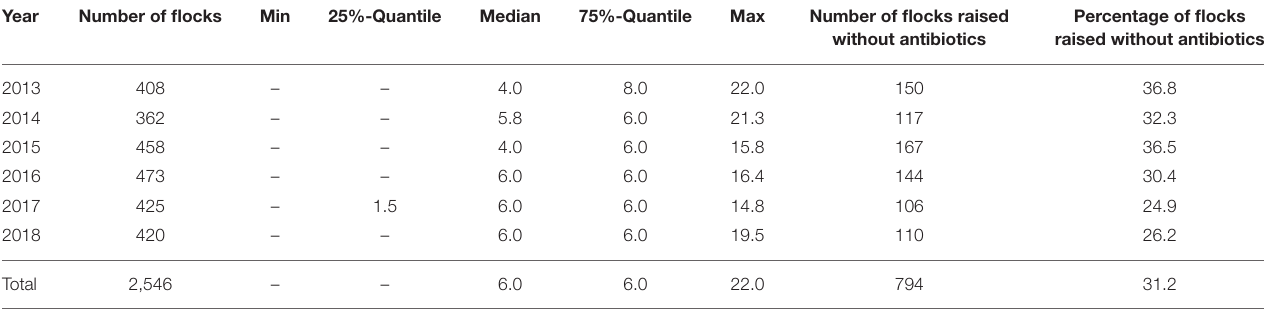
TABLE 1 | Major measures of the statistical distribution of the overall TF at the flock level and percentage of flocks raised without AMU per year. Year Number of flocks Min 25%-Quantile Median 75%-Quantile Max Number of flocks raised